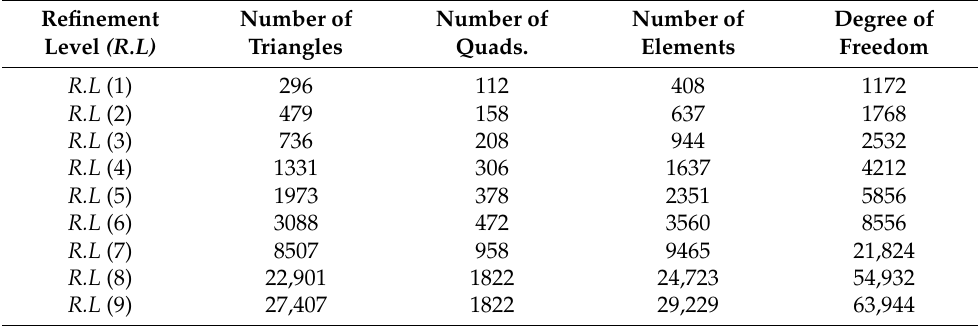
Table 1. Number of elements and degree of freedom for different refinement levels (R.L’s). Refinement